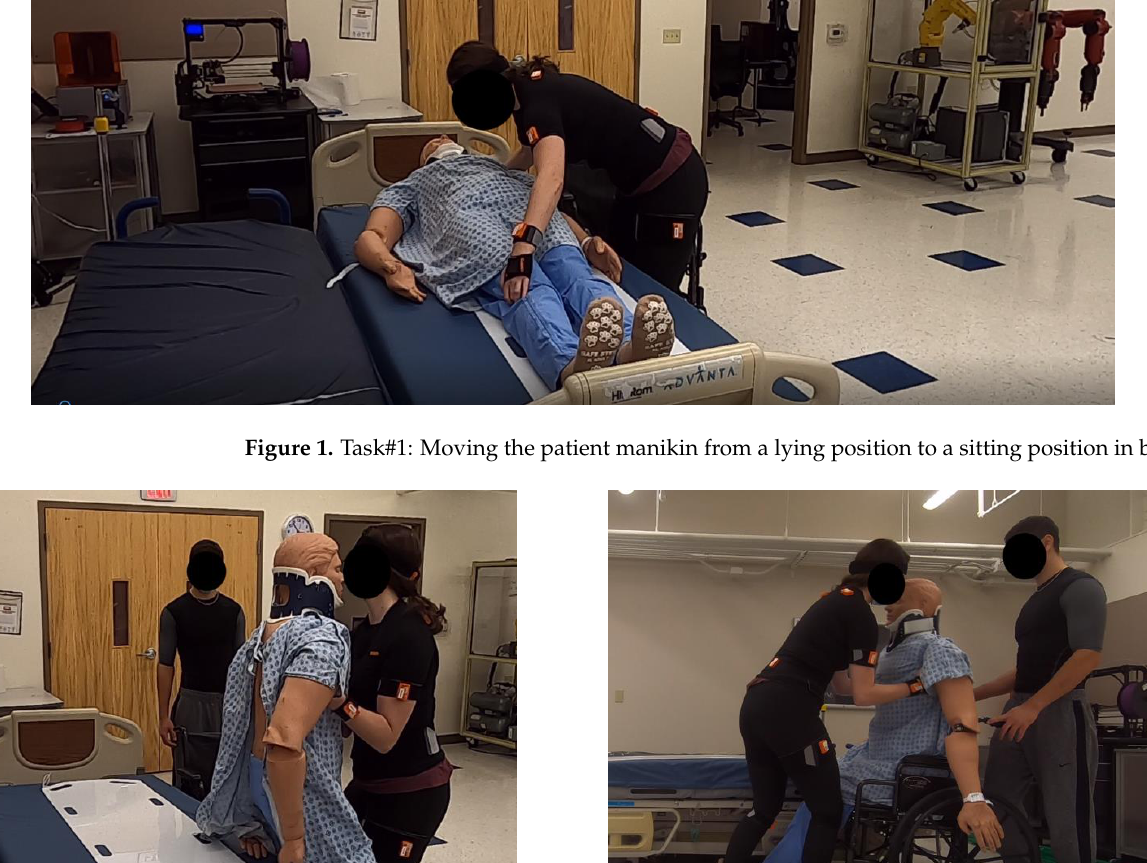
Figure 2. Task#2: Transferring the patient manikin from a bed to a wheelchair. ( a ) Moving the man- ikin from the hospital bed. ( b ) Placing the manikin into the wheelchair.